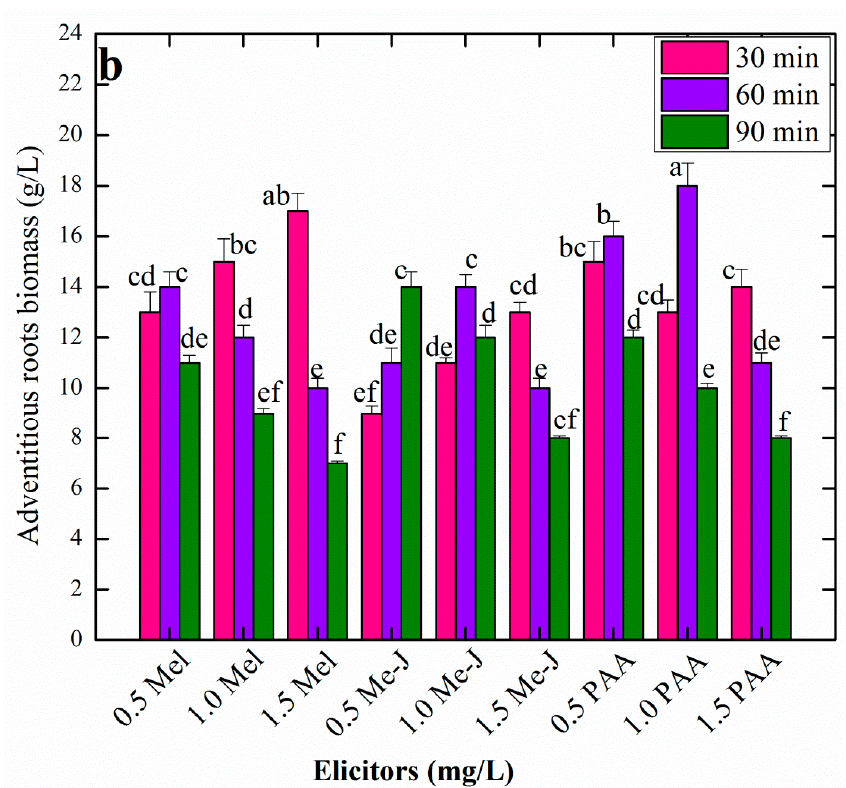
Figure 2. E ff ects of pretreatment of AR with di ff erent elicitors for di ff erent time periods on growth and biomass of AR in MS liquid media containing 1.0 mg / L NAA and 3% sucrose. ( a ) Percent AR morphogenetic response and ( b ) AR fresh biomass (g / L). Data represent the mean values of triplicates with ± standard error for each treatment in three repeated experiments. Annotation of columns data with di ff erent alphabet (s) represents the significance at ( P =